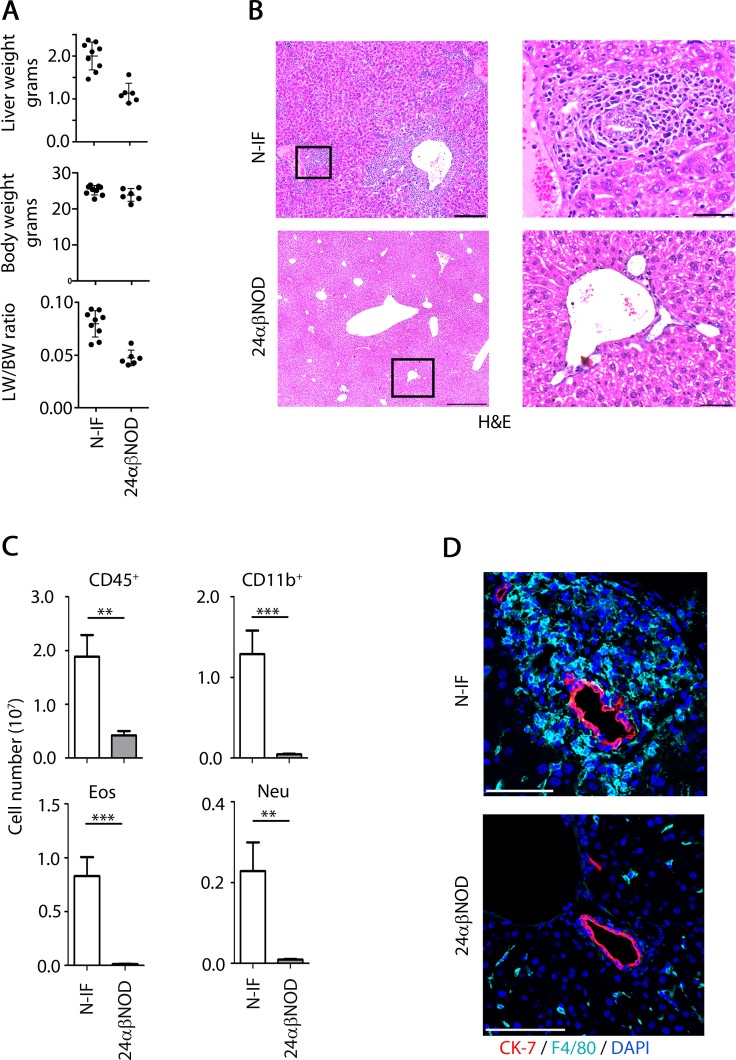
Hepatic inflammation and abnormal intrahepatic bile ducts in the N-IF mouse.(A) Liver weight (LW), body weight (BW) and LW/BW ratio of 8 weeks old, female N-IF mice (left, n = 9) and of aged matched female 24αβNOD control mice (right, n = 5); (B) H&E stained liver sections from 10–12 weeks old, female N-IF and 24αβNOD control mice. Squared areas are highlighted. Images shown are representative images from three independent experiments with a total of eight mice. Scale bars are 100 μm in the overview images (left) and 50 μm in the highlighted images (right). (C) Flow cytometry analysis of viable liver leukocytes from N-IF and 24αβNOD mice (n = 9). Number of leukocyte (CD45+), CD11b+ cells gated from viable CD45+ cells and eosinophils (Eos) and neutrophils (Neu) gated from the CD11b+ population and defined as being SiglecF+ and Ly6G+ respectively. Data are pooled from three independent experiments and shown as mean ± SEM. **p<0.01 and ***p<0.001 by unpaired t-test. (D) Immunofluorescence staining of bile ducts (CK-7, red), macrophages (F4/80, light blue) and nuclei (DAPI, blue) in livers of 8 week old N-IF and 24αβNOD control mice. Representative images from two independent experiments with a total of six mice are shown. Scale bars are 100 μm.